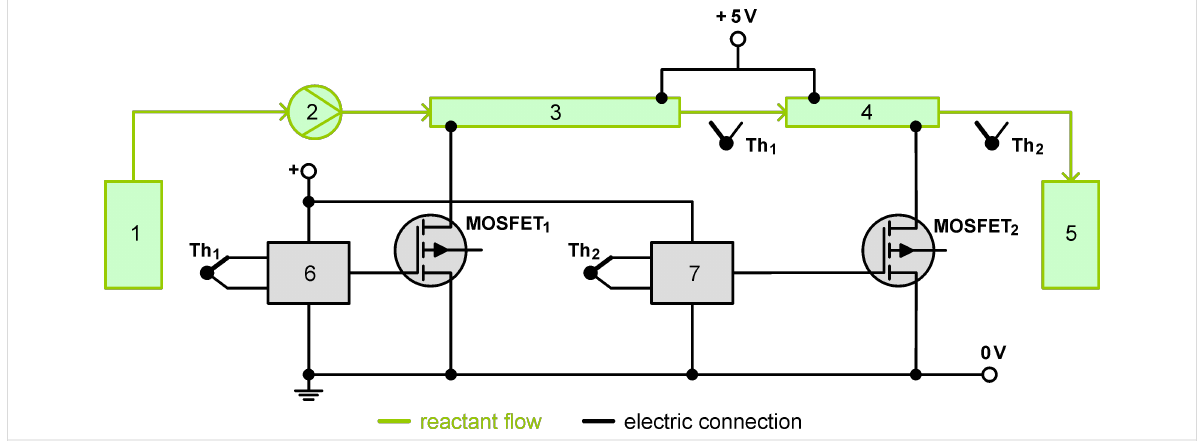
Figure 1: Experimental setup for catalyst synthesis in the tubular flow reactor; 1: Reaction mixture reservoir, 2: Peristaltic pump, 3: Preheating tube, 4: Heating tube, 5: Catalyst reservoir, 6: Temperature controller with thermocouple 1 (Th 1 ), 7: Temperature controller with thermocouple 2 (Th 2 ).